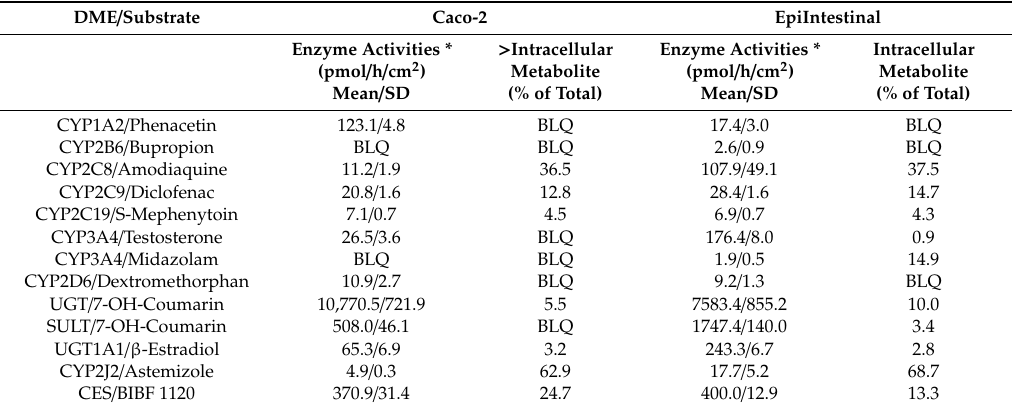
Table 4. Determination of activities of DMEs in EpiIntestinal microtissues and Caco-2 cells. Enzyme activities in EpiIntestinal microtissues and Caco-2 cells in 96-well Transwell plates were measured with mean and SD from triplicates.